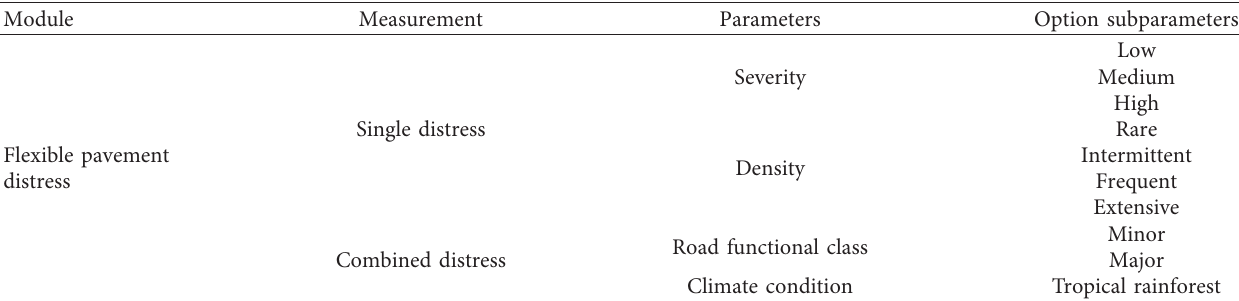
Table 4: Examples of facts contained in the working